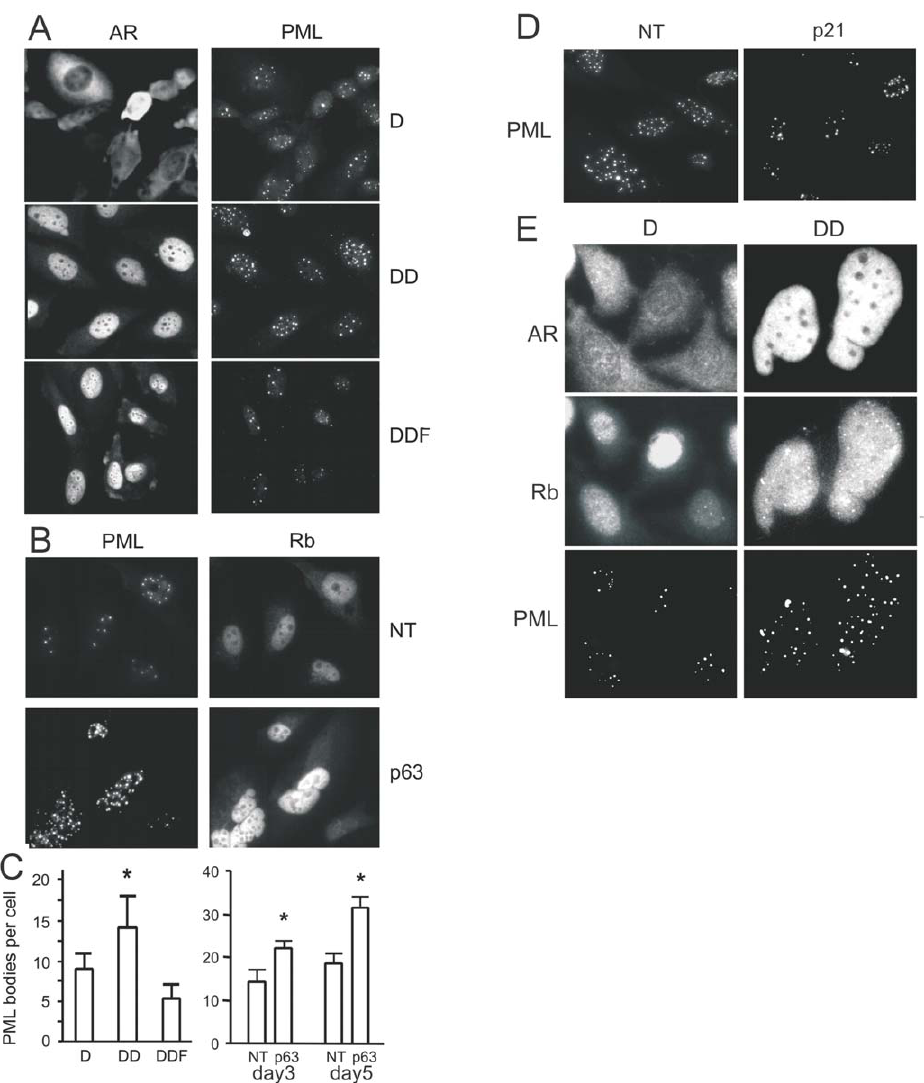
Figure 6. AR alters PML aggregation via p63 pathway. PML tumor suppressor was linked to AR dependent senescence. ( A, C ) PC3-AR cells were cultured in Dox (D) and treated with DHT (DD) or DHT and Fl (DDF) for 48 hours and stained for AR, to assess activation state, and for PML (A). The number of PML bodies per 20 6 field was measured using MetaMorph software and recalculated per single cell (C, left). Note a significant increase in the number of PML bodies/cell in the presence of DHT (P , 0.02), but not in the presence of Fl. ( B, C ) PC3-AR cells were transfected with NT or p63 siRNA, cultured for 3 and 5 days and stained for PML and Rb. The number of PML bodies per cell was calculated as above (C, right). Note a robust decrease in PML staining upon p63 knock-down (day 3, P , 0.05; day 5, P , 0.0001). ( D ) PC3-AR cells were transfected with non-target (NT) or p21 siRNA, treated for 3 days with DHT and stained for PML. Note decreased staining upon p21 knock-down. ( E ) PC3-AR treated 3 days with Dox 6 DHT and stained for AR, Rb and PML. Note AR activation and nuclear translocation, concomitantly increased intensity of Rb staining with appearance of partial aggregation, and co-localization of Rb aggregates with PML nuclear bodies.